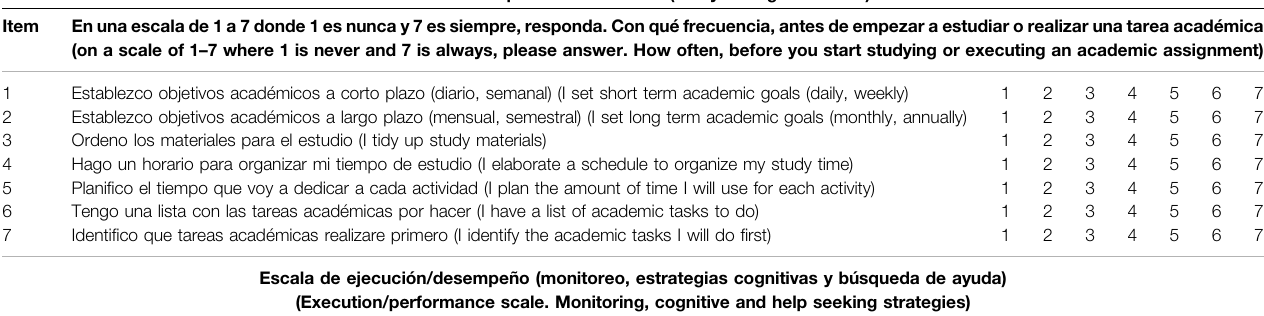
TABLE 2 | Scales to assess self-regulation of learning phases with Likert scales 1 to 7 Escala de disposición al estudio (study willingness scale)